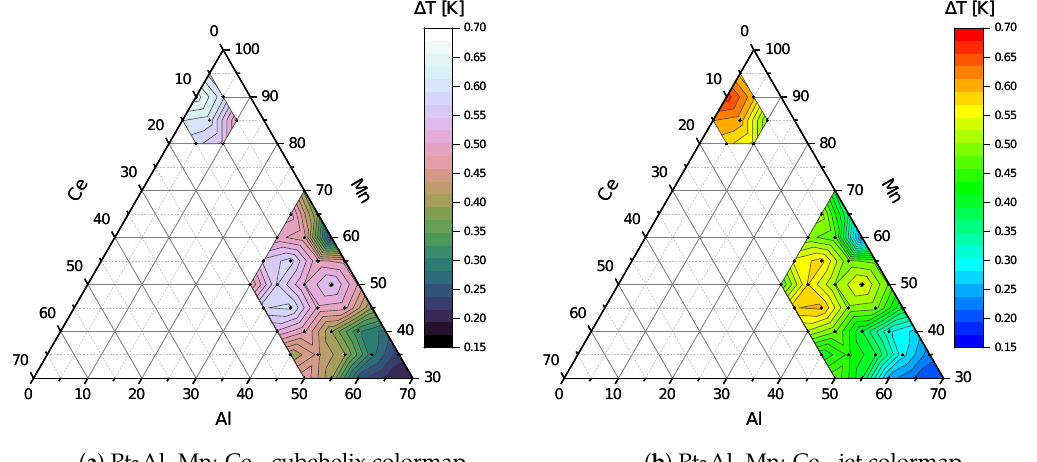
012 ( a ) Cubehelix colormap. Figure 7. Results of ecIRT measurement for slate library plate 2 containing 172 samples from composition ranges Pt 3 Al a Mn b Ce c and Pt 1.5 Rh 1.5 Al a Mn b Ce c , compositions from Figure 6 displayed using different colormaps. Samples have been placed randomly on the slate library plate. 2vol.% CH 4 , 8vol.% O 2 , 12vol.% H 2 O, balance N 2 , 400 ◦ C.